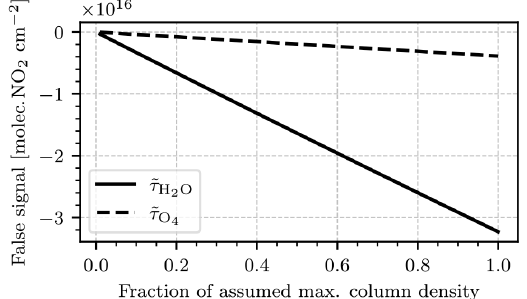
Figure 8. Modeled cross-sensitivity to H 2 O and O 4 . The ordi- nate shows the fraction of the assumed maximal column den- sity for both species, which are 6 · 10 23 molec.cm − 2 for H 2 O and 10 44 molec. 2 cm − 5 for O 4 . The abscissa shows the false signal of the two species converted to NO 2 column density equivalents. The calibration of the model was obtained from Fig. 4, assuming a col- umn density of S c = 4 · 10 18 molec.cm − 2 in the gas